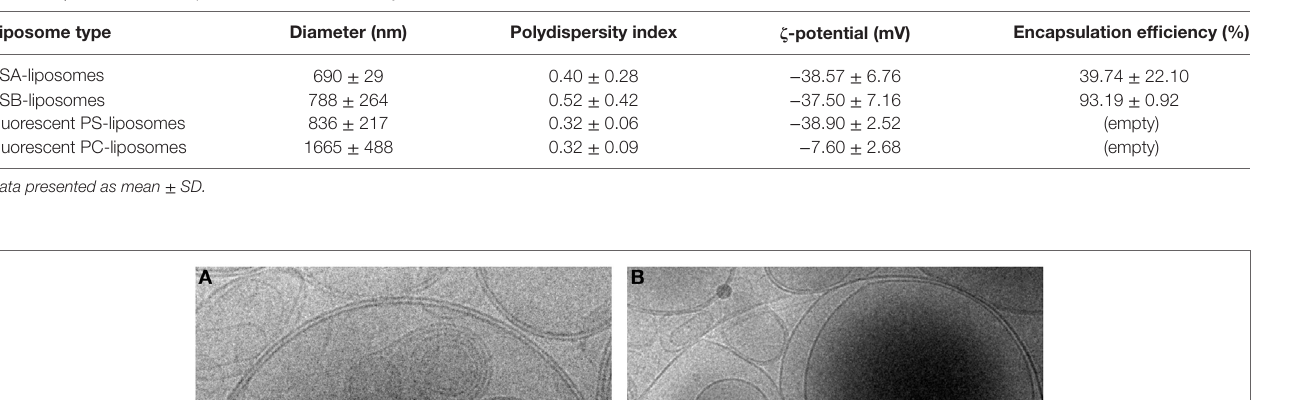
Table 4 | Features of the liposomes used in the study.